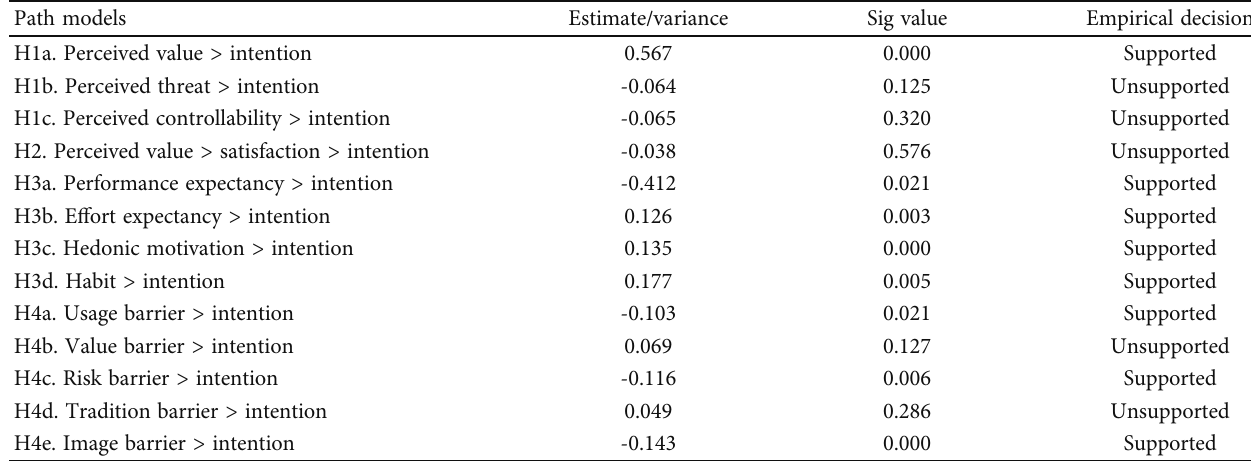
Table 4: Hypotheses assessment